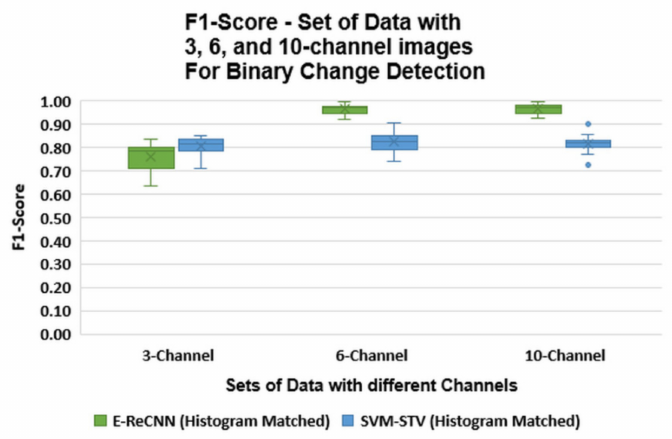
Figure A3. Binary change detection best performance.